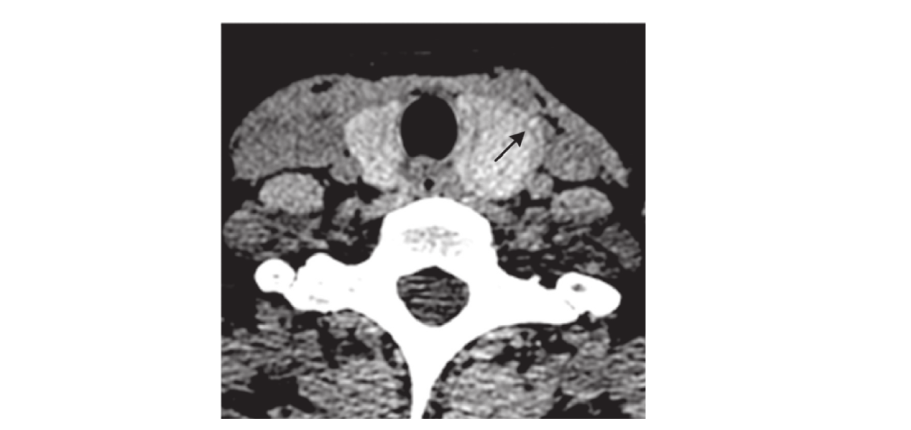
Figure 4: Thyroid left lobe nodule, in a female, 45 years old. Plain CT scan showing smooth low-density ring sign ( ↑ ) around the nodule, pathologically confirmed as nodular